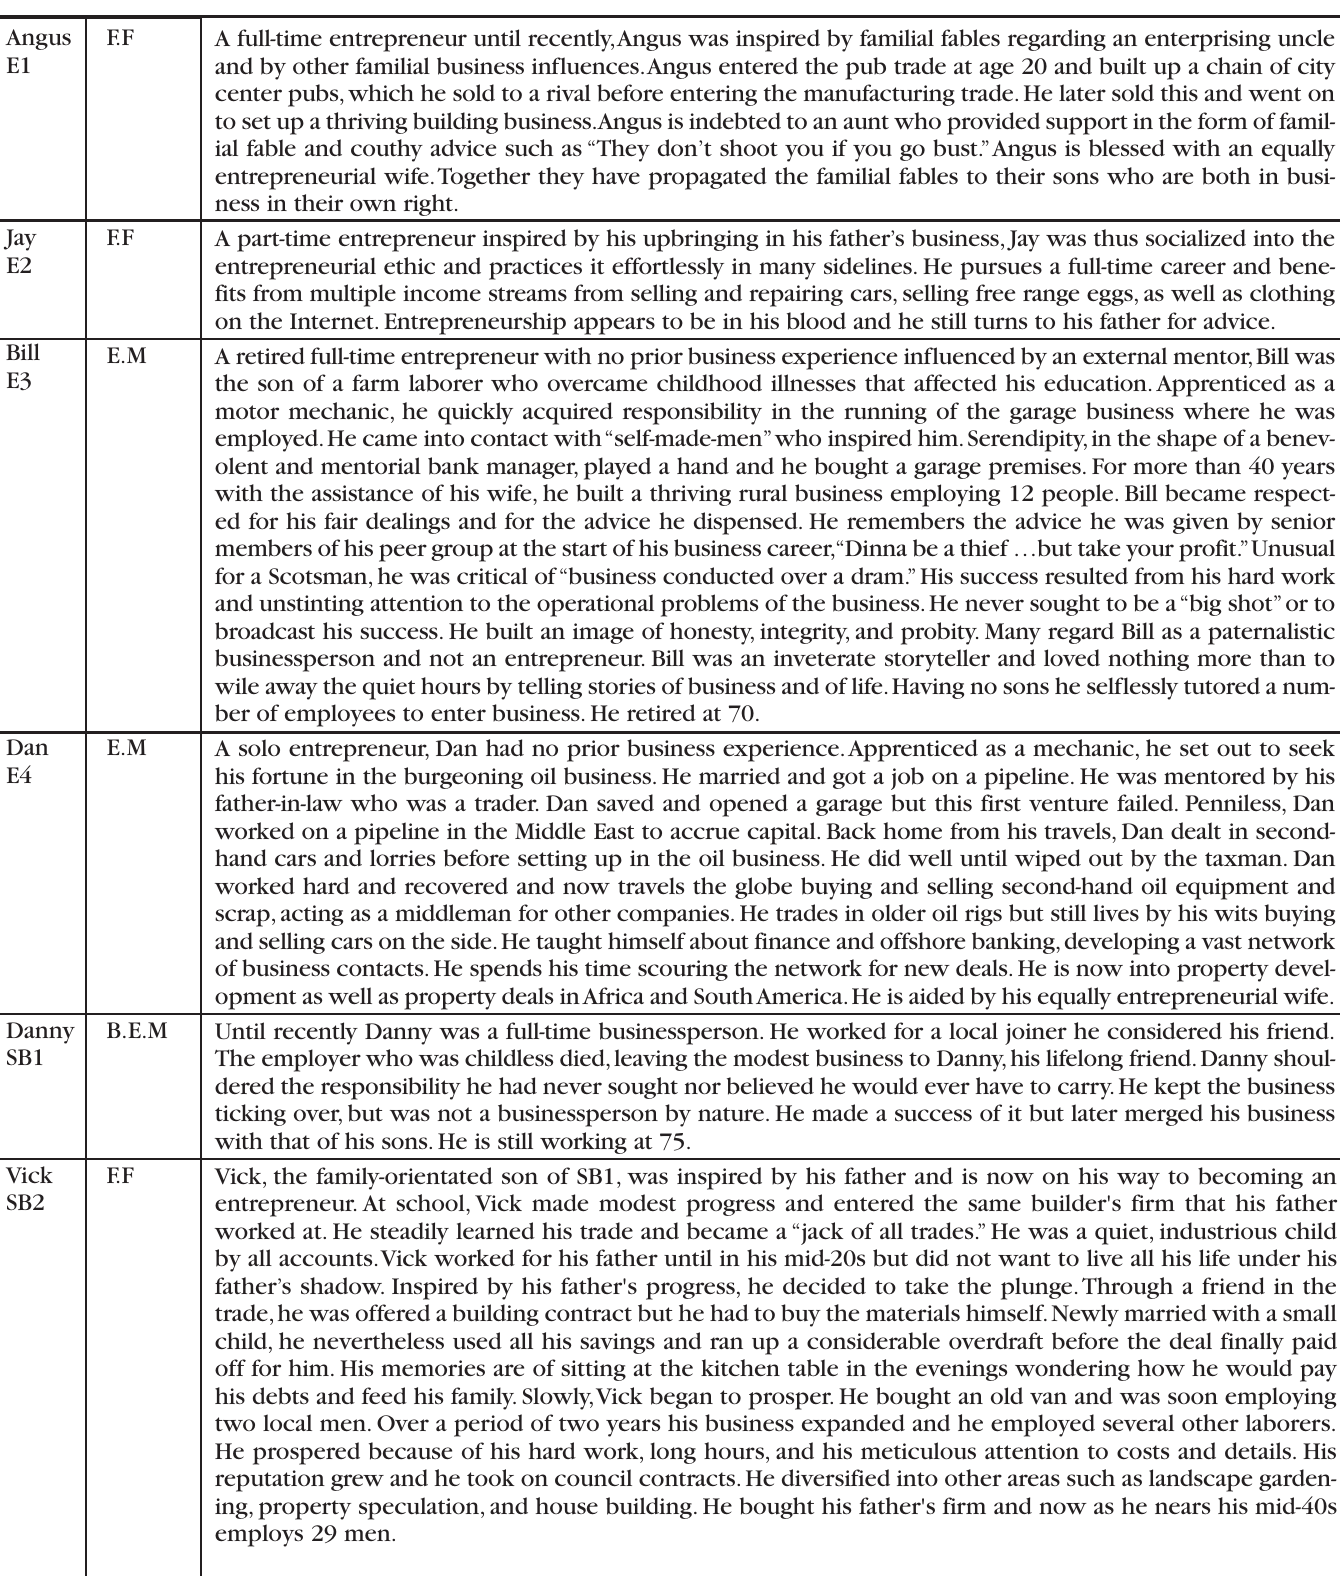
Table 3. Personal History of Respondents Divided into Inspirational Typologies A full-time entrepreneur until recently,Angus was inspired by familial fables regarding an enterprising uncle and by other familial business influences.Angus entered the pub trade at age 20 and built up a chain of city center pubs,which he sold to a rival before entering the manufacturing trade.He later sold this and went on to set up a thriving building business.Angus is indebted to an aunt who provided support in the form of famil- ial fable and couthy advice such as “They don’t shoot you if you go bust.”Angus is blessed with an equally entrepreneurial wife.Together they have propagated the familial fables to their sons who are both in busi- ness in their own